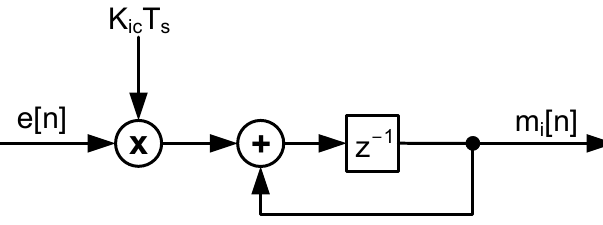
Figure 10. Digital I-term block diagram.